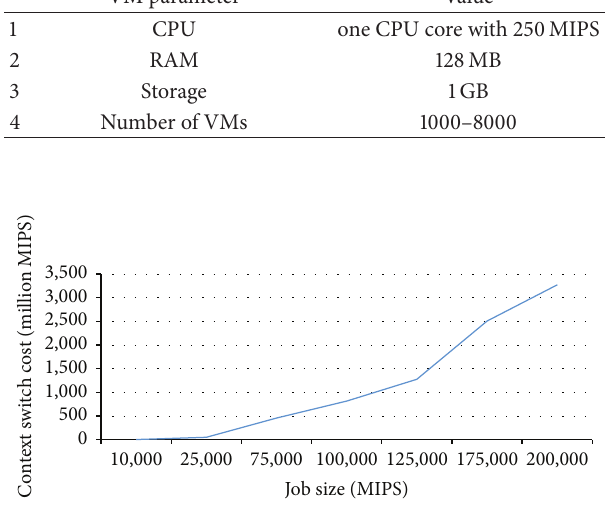
Figure 3: Indirect context switch cost and the job size.